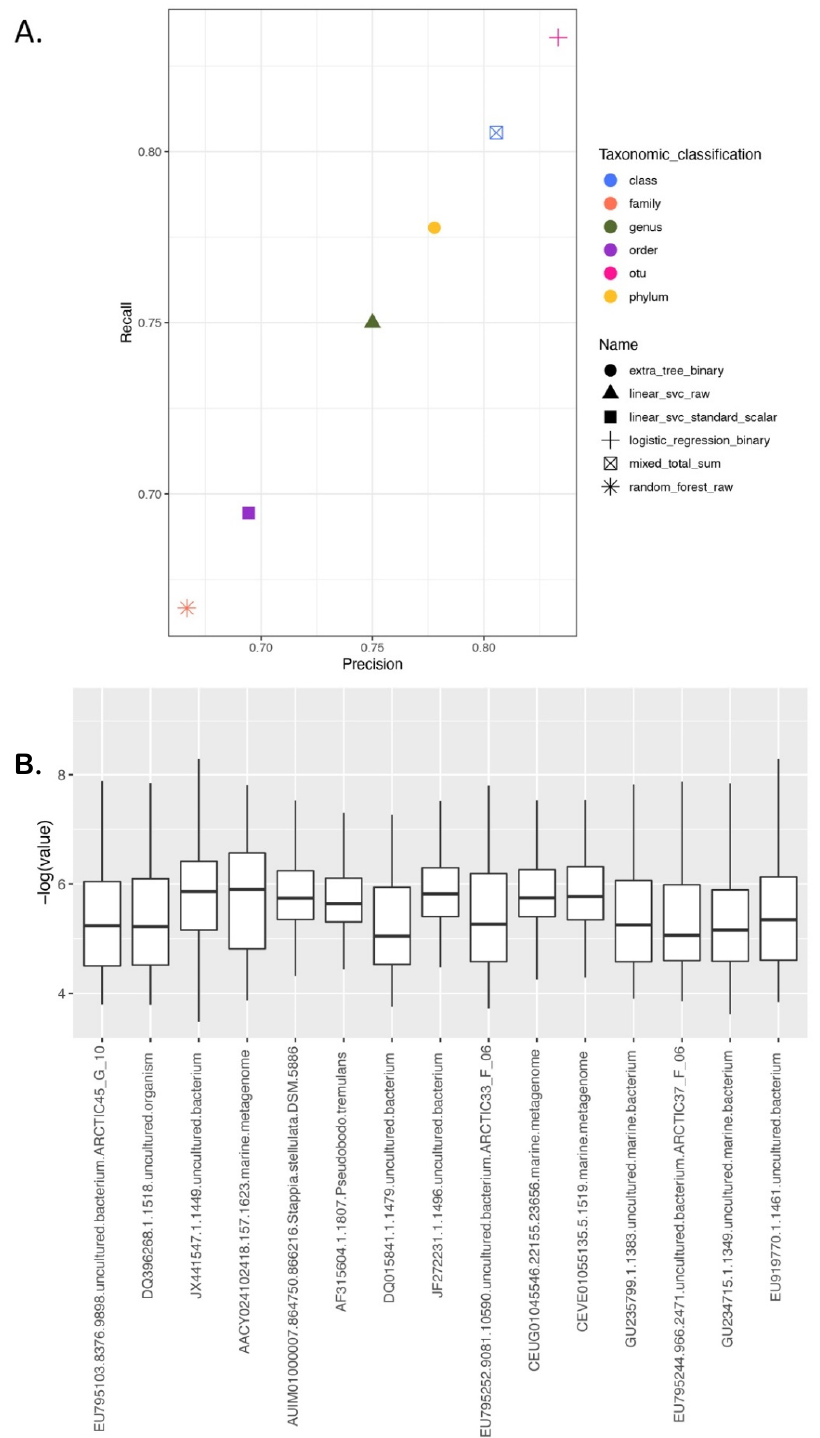
Figure 4. Validation using the Tara Oceans dataset shows the presence of microbial fingerprints in the water sample: ( A ) Precision vs. Recall for the best model for prediction at each category to predict geolocation based on ocean region. We observe that irrespective of being the same dataset when we try classifying based on different domains, the best model/preprocessing differ, even if they are able to achieve similar accuracy. ( B ) Top 15 OTUs selected by Cassandra from Tara datasets along with their weight assigned by Cassandra.